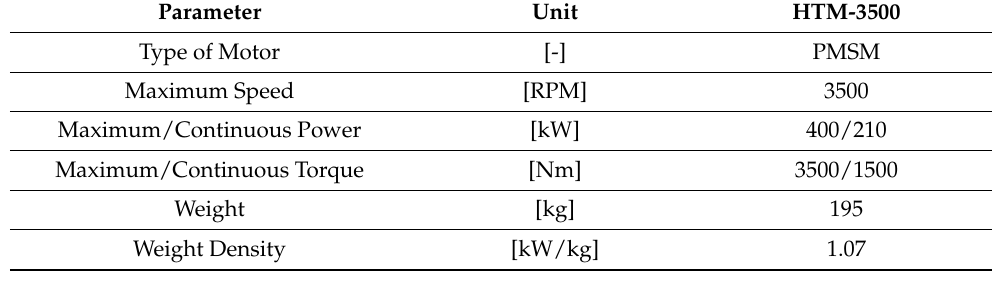
Table 2. Electric motor main characteristics. Source [24].